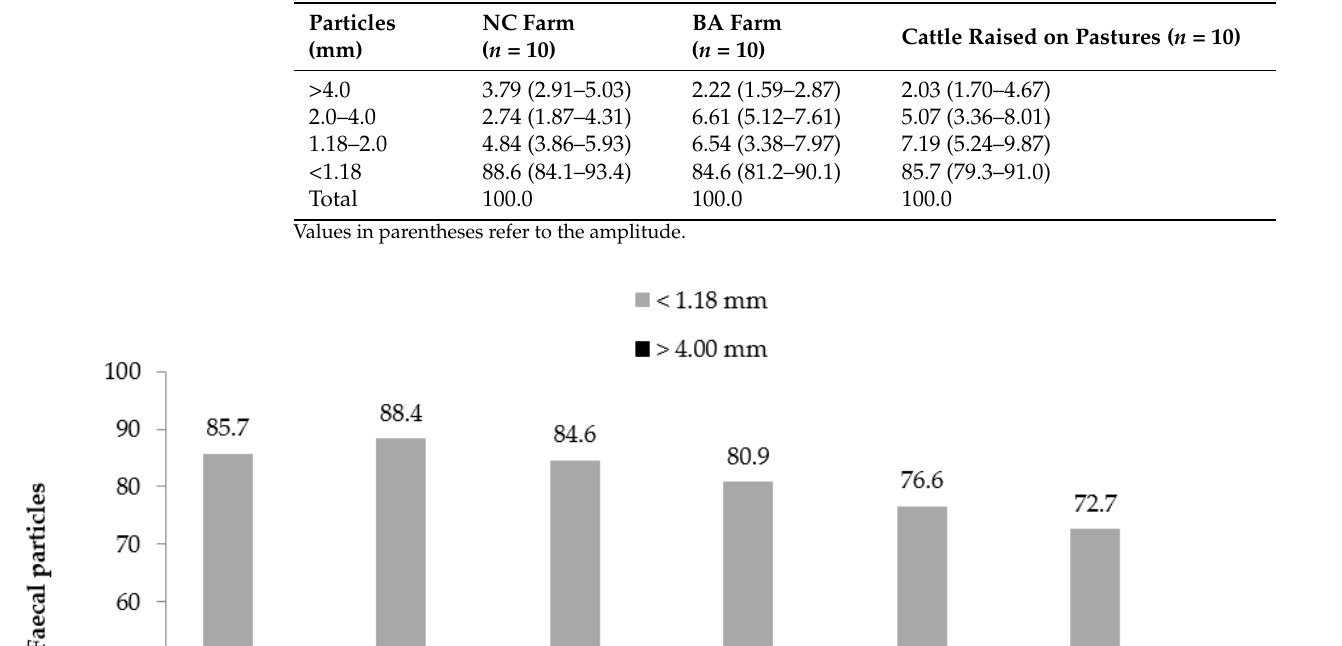
amplitude. Table 10. Overall means of fecal particle size of cattle submitted to the diets of the two sire production systems and of the animals raised on pasture only. Values expressed in %.